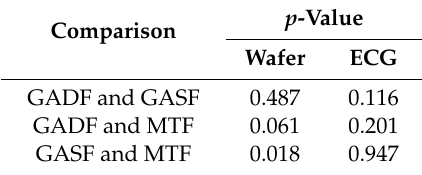
Table 2. The p -values of the Dunn Test in the RGB Wafer and ECG datasets images.